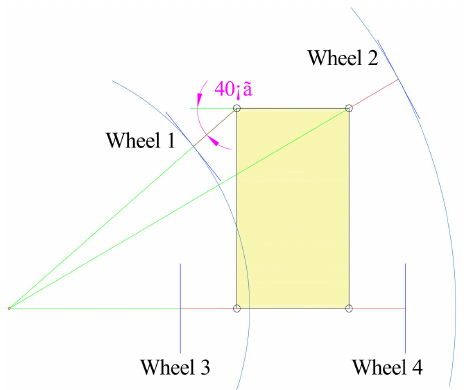
Figure 9. Schematic diagram for the maximum value of the steering wheel